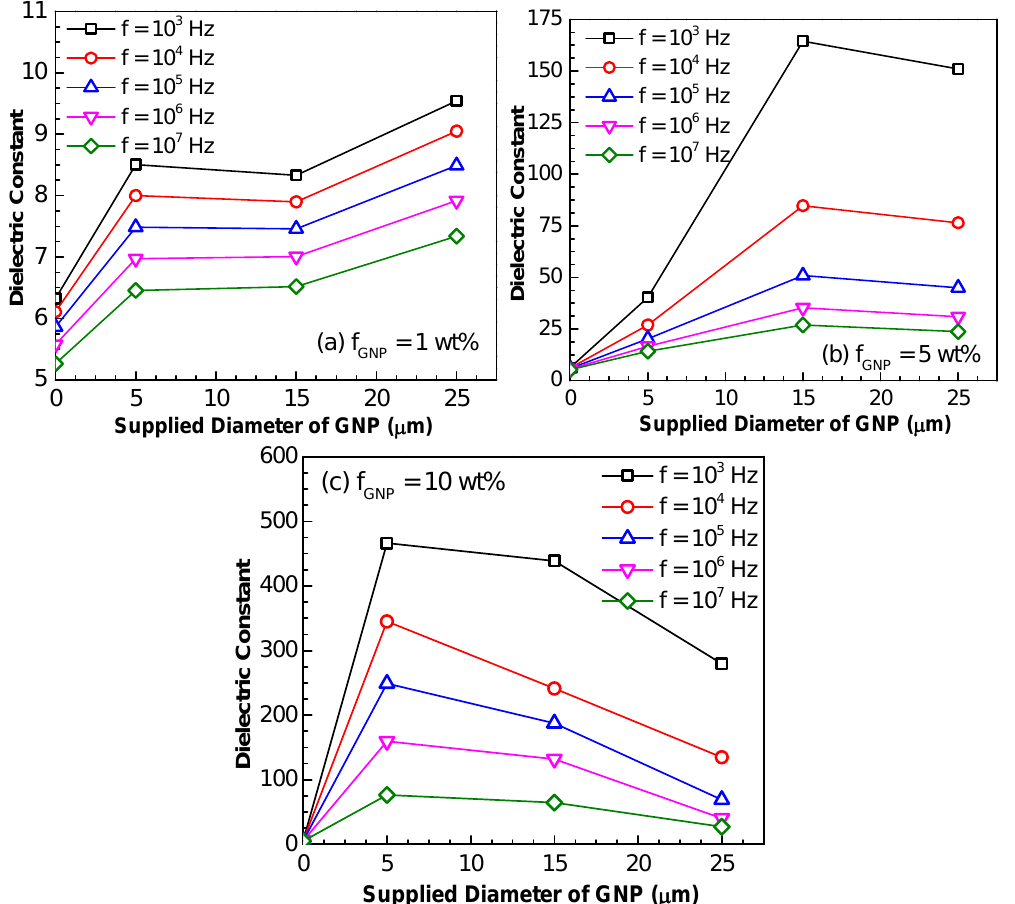
Figure 11. Dielectric constant of GNP/epoxy nanocomposites ( a ) f GNP = 1.0 wt %; ( b ) f GNP = 5.0 wt %; ( c ) f GNP = 10.0 wt %.